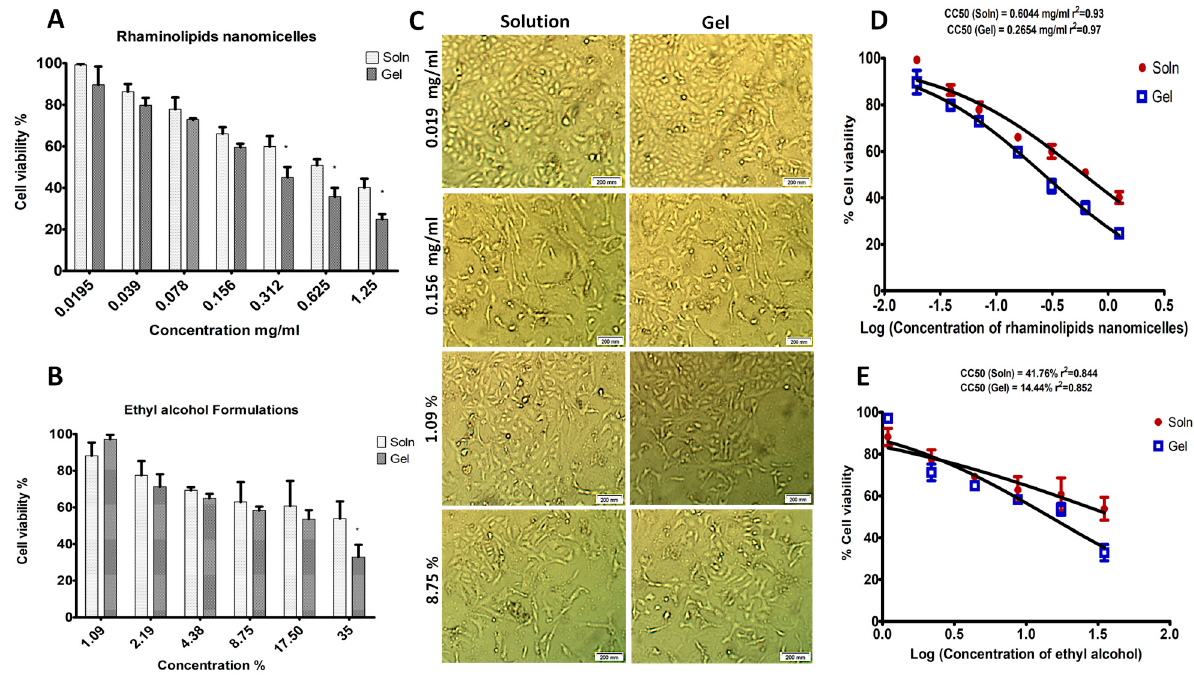
Figure 6. MTT cytotoxicity study of rhamnolipid nano-micelles and ethyl alcohol formulations on normal human dermal fibroblasts (HDFa): ( A ) Cell viability percentage of HDFa after treatment with different concentrations (0.0195 to 1.25 mg/mL) of rhamnolipid nano-micelle solution and gel. ( B ) Cell viability percentage of HDFa after treatment with different concentrations (1.09 to 35%) of ethyl alcohol solution and gel. Significant differences in the cytotoxic effects of rhamnolipid nano-micelles and ethyl alcohol formulations on HDFa cells are denoted with asterisks * at p < 0.05. ( C ) Phase-contrast microscopy images of rhamnolipid nano-micelle formulations at concentrations of 0.019 and 0.156 mg/mL, and of ethyl alcohol formulations at concentrations of 1.09% and 8.75%. Determination of the cytotoxic concentration responsible for the death of 50% of HDFa cells (CC50) for ( D ) rhamnolipid nano-micelle solution (0.625 mg/mL) and gel (0.2654 mg/mL), and ( E ) ethyl alcohol solution (41.76%) and gel (14.44%). Results are an average of three independent experiments with three replicates each.